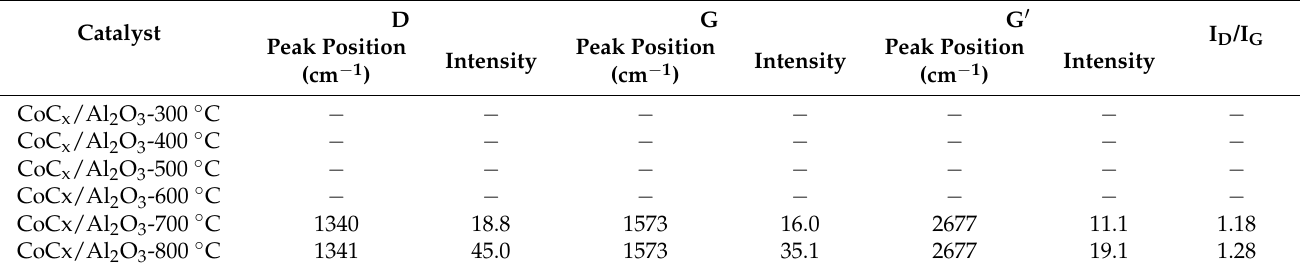
Table 2. Raman spectra for carbonaceous materials observed in the prepared